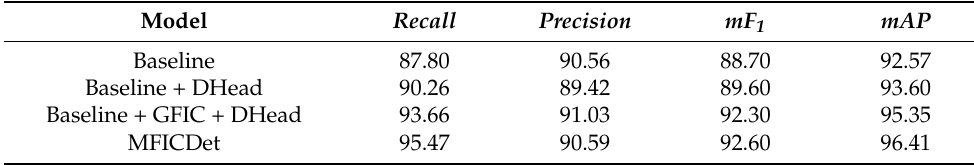
Table 3. Results of ablation experiments in the NWPU VHR-10 dataset.